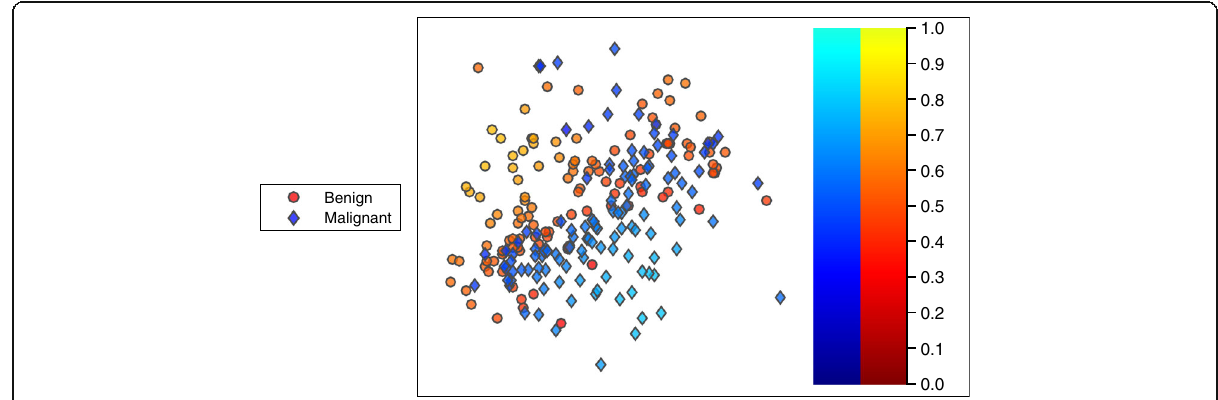
Fig. 2 An inferred two-dimensional embedding for 237 skin lesion images. Each dot represents a unique image where the color of the dot indicates the image category ( reddish : benign, bluish : malignant). The brightness of the color indicates the Ease value of the exemplar. The brighter colors ( yellow and cyan ) indicate exemplars that are relatively easy. The darker colors indicate exemplars that are relatively